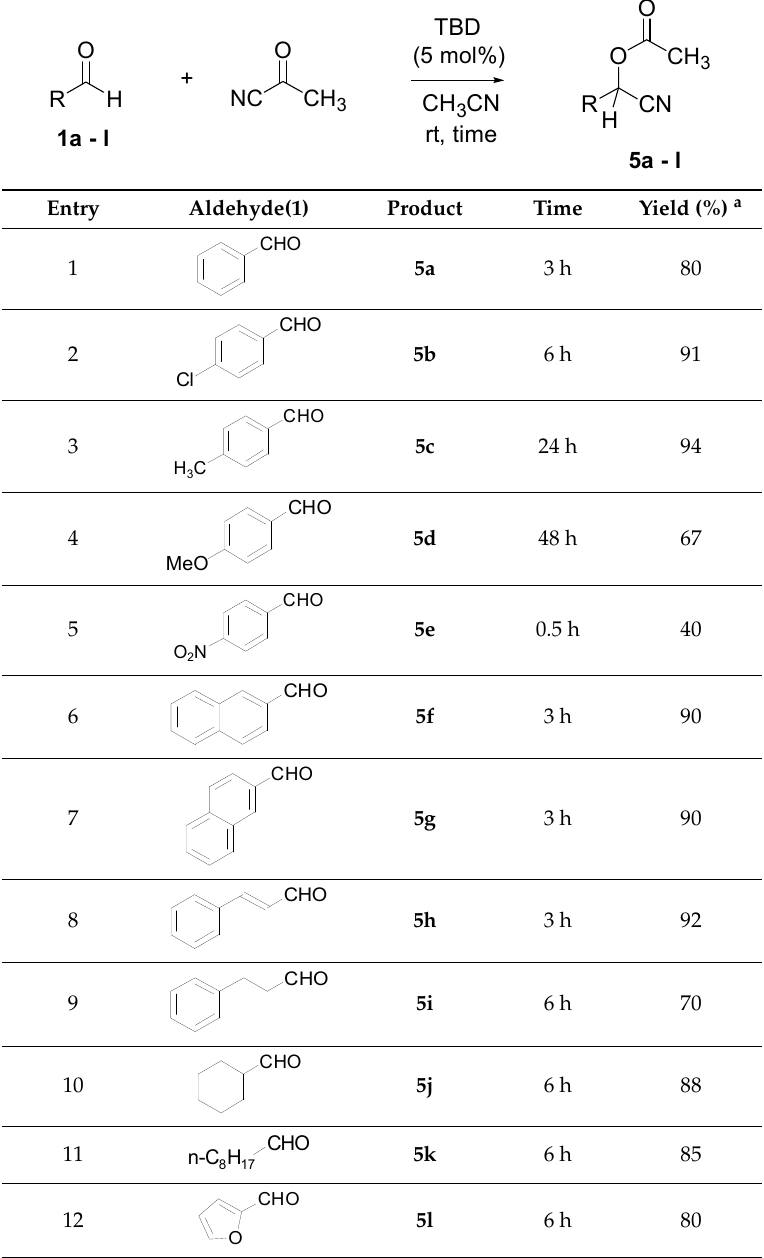
Table 3. TBD catalyzed cyanation of aldehydes with acetyl cyanide.